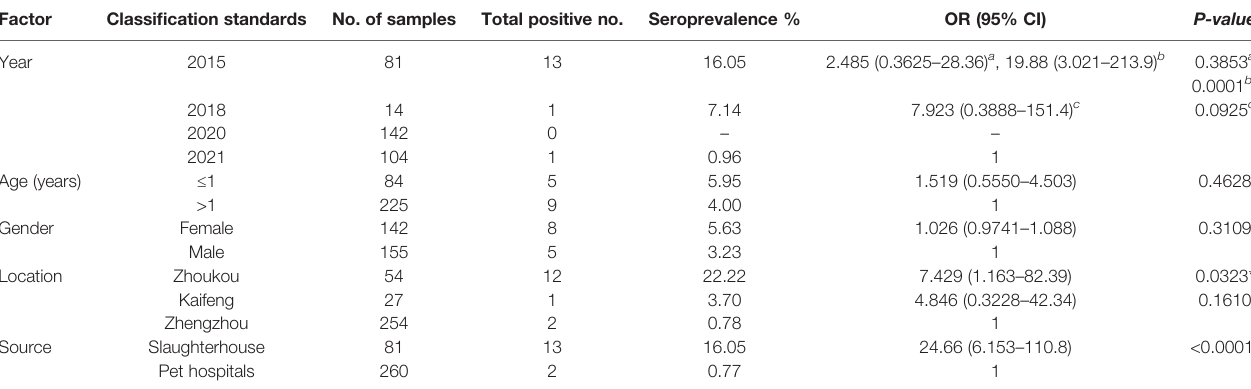
TABLE 3 | Seroprevalence and risk factors of Toxoplasma gondii infection in dogs tested by a modi fi ed agglutination test (MAT). Factor Classi fi cation standards